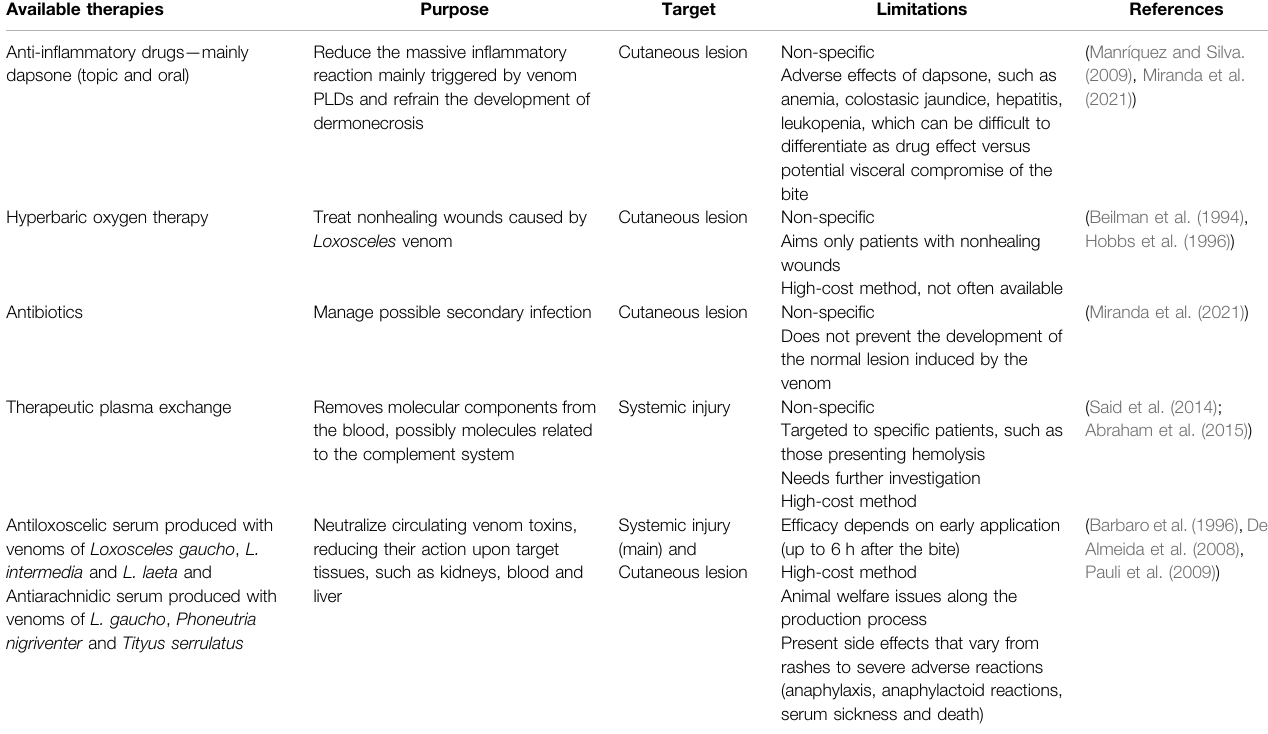
TABLE 1 | Available therapies used to treat loxoscelism — summarization of their features and basic references on the